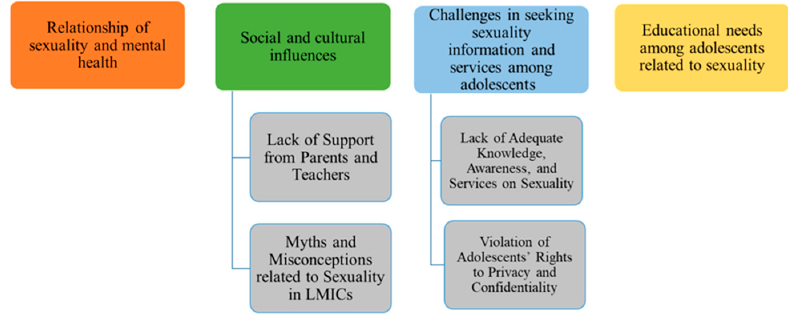
Figure 2. Diagram showing Themes and